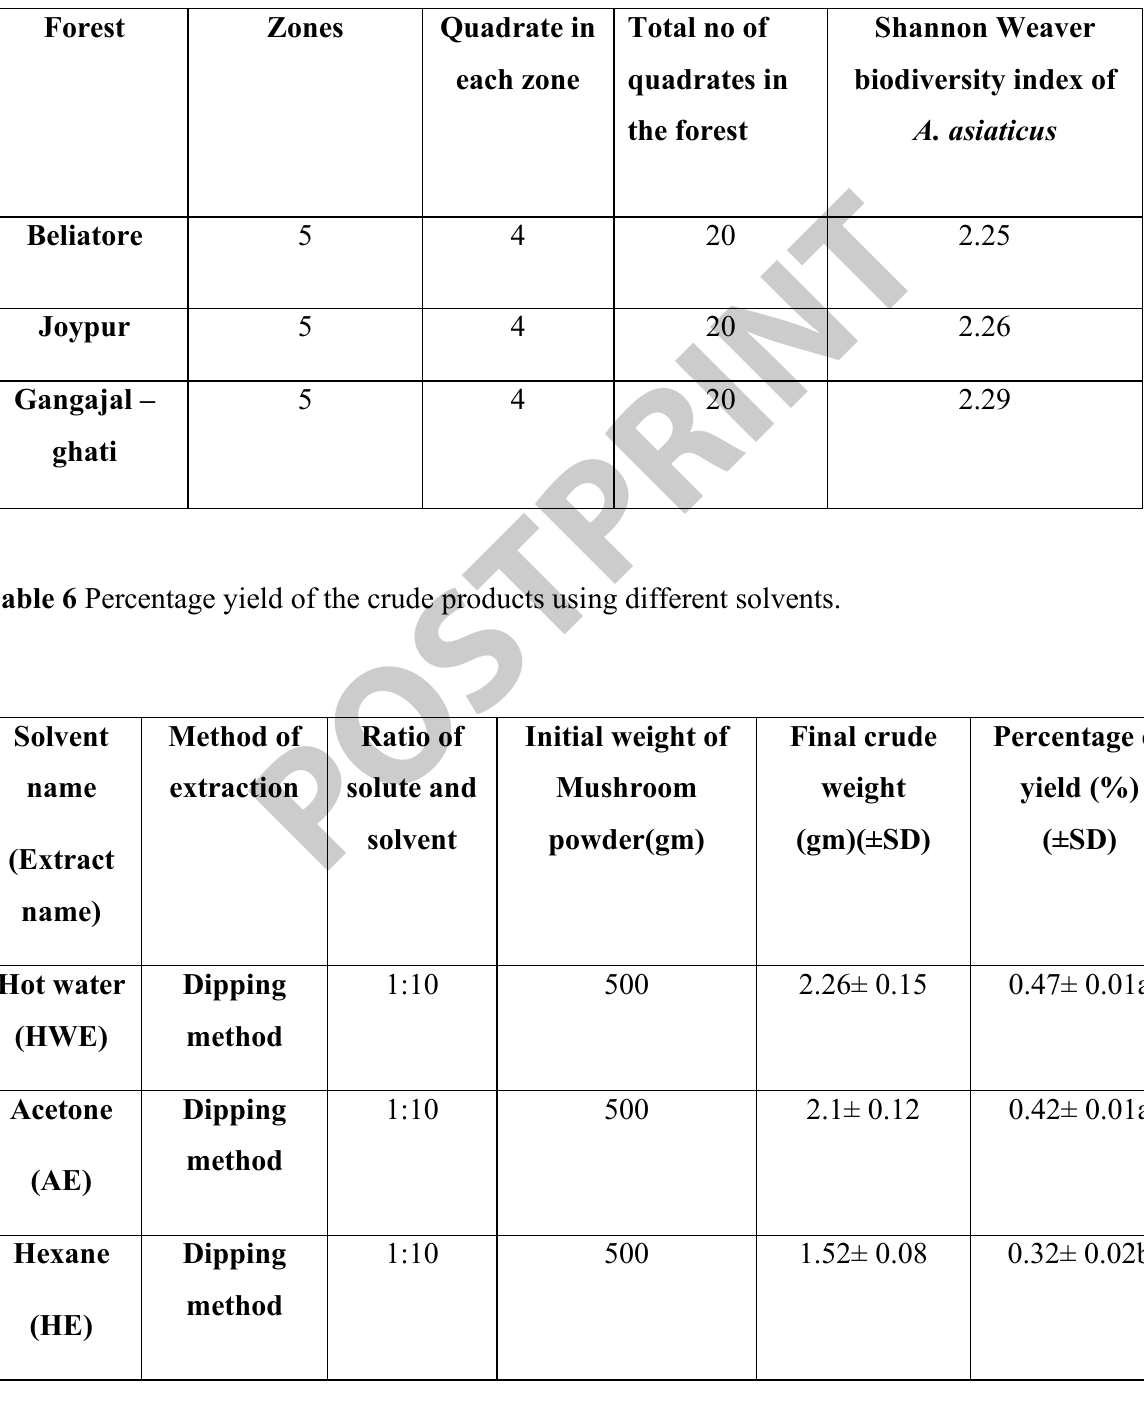
Table 5 Shannon Weaver biodiversity index of the association between Astraeus asiaticus and Modhuca indica.